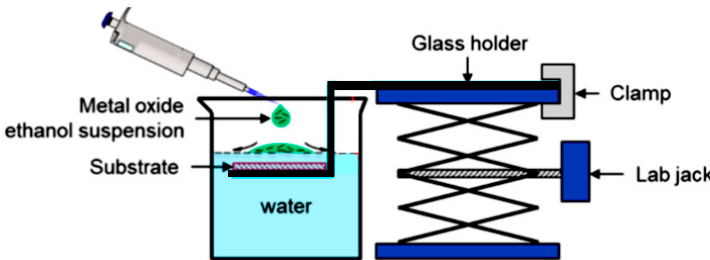
Figure 47. ( a ) SEM images of as-synthesized CuO nanosheets; ( b ) low-magnification TEM image of CuO nanosheets and the SAED pattern and a sketch of the crystal orientation in the real space as inset; ( c ) top surface SEM image of the CuO nanosheet monolayer on the glass substrate. Reproduced from Miao et al. [406]. Published by ACS as open access.